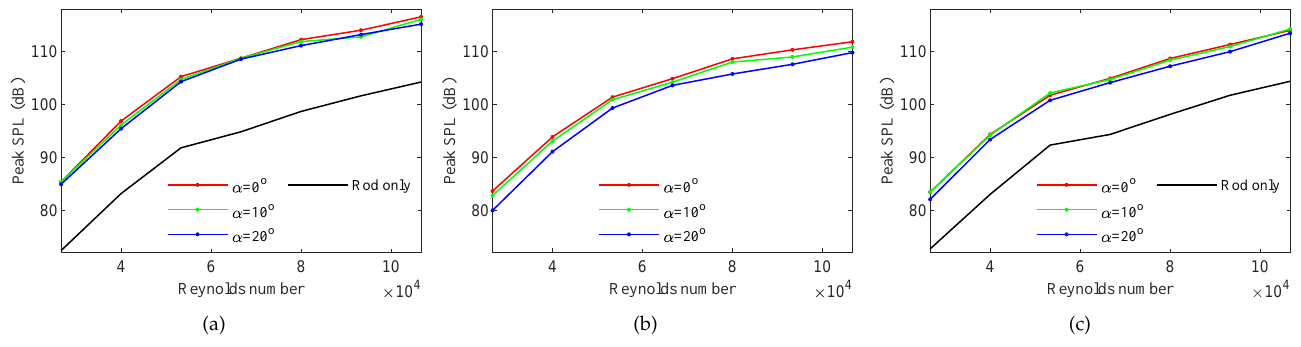
Figure 4. The main peak value of the acoustic spectra at different airfoil attack angles: L = ( a ) 100 mm, ( b ) 140 mm, and ( c ) = 200 mm.